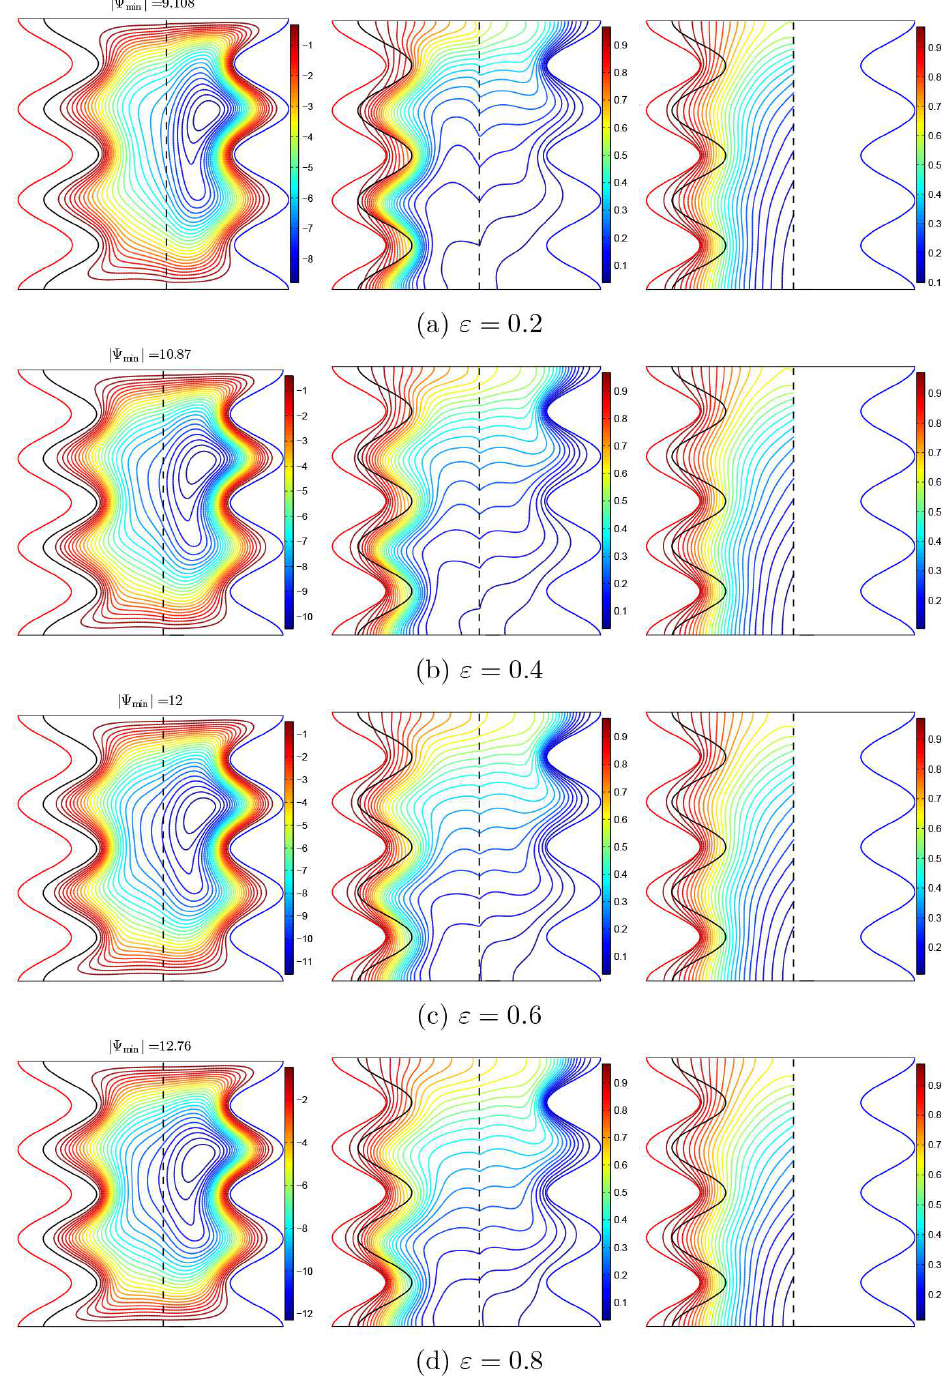
Figure 11. Streamlines ( left ), the isotherms of the nanofluid phase ( middle ), and the isotherms of the solid phase ( right ) with various porosities of the medium ( ε ); Da = 10 − 3 , φ = 0.02, γ = 10, and A =